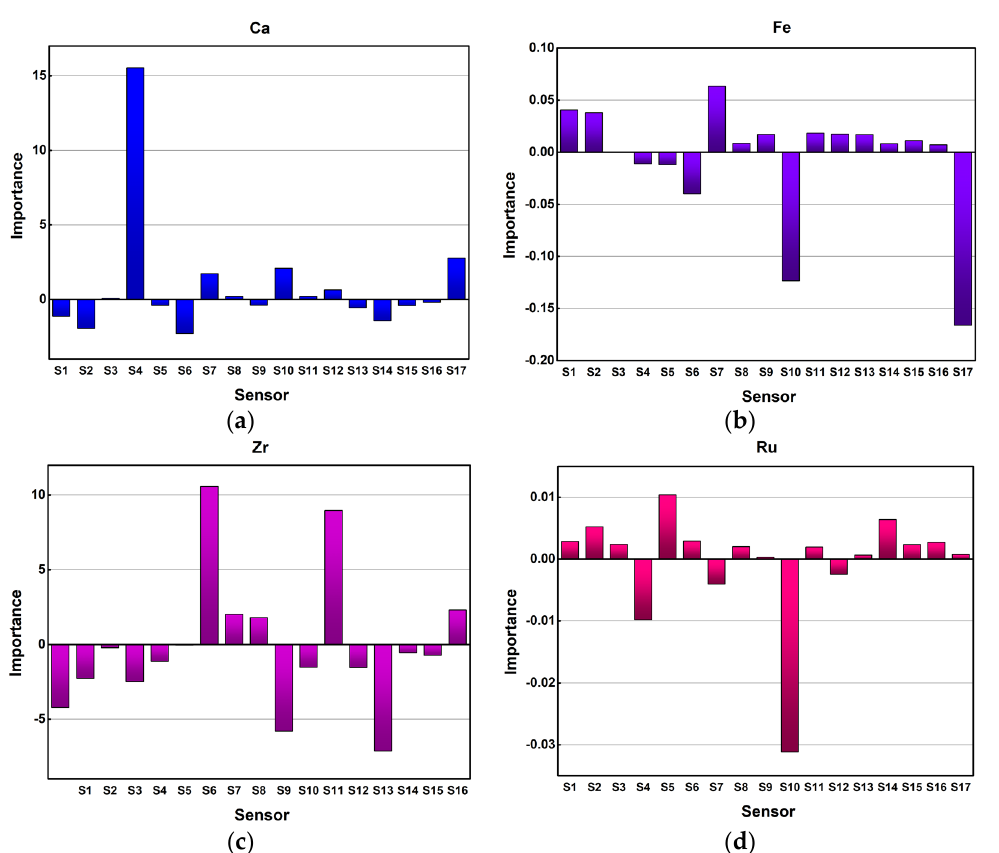
Figure 3. The importance of sensors in determining the concentrations of Ca ( a ), Fe ( b ), Zr ( c ), and Ru ( d ). Table 2. RMSEP values for quantification of U, Sm, Am, and Cm in PUREX solutions. #Samples in Element